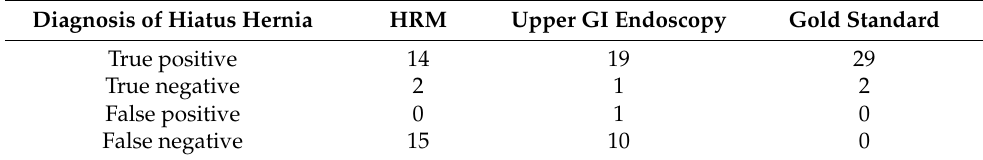
Table 1. Detection of hiatus hernia by either HRM or upper GI endoscopy, or both. Diagnosis of Hiatus Hernia HRM Upper GI Endoscopy Gold Standard True positive 14 19 29 True negative 2 1 2 False positive 0 1 0 False negative 15 10